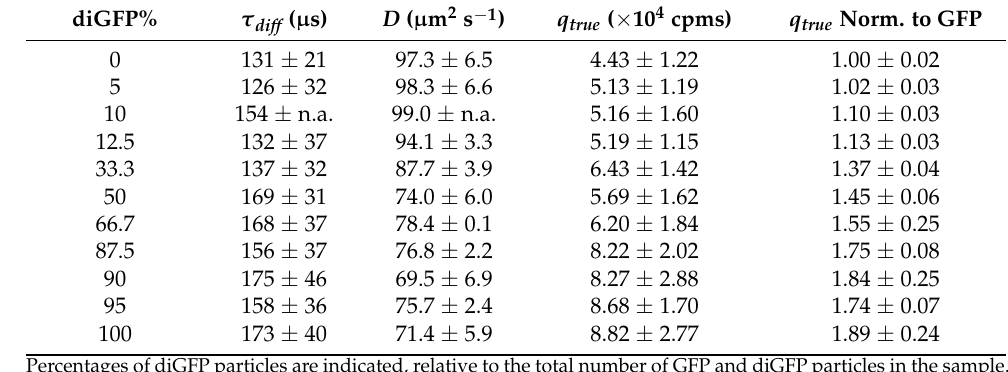
Figure 2. Average brightness of various GFP-diGFP mixes in cell lysate. Percentages of diGFP particles are relative to the total number of GFP and diGFP particles in the sample. Average true brightness is calculated as in Table 2, normalized to GFP per day. Error bars indicate standard deviations. The black line indicates the linear fit (R 2 = 0.9837). The dashed line indicates the theoretical expected values, when a dimer would be twice as bright as a monomer. Table 2. Diffusion rate and brightness of various GFP-diGFP mixes in cell lysate.